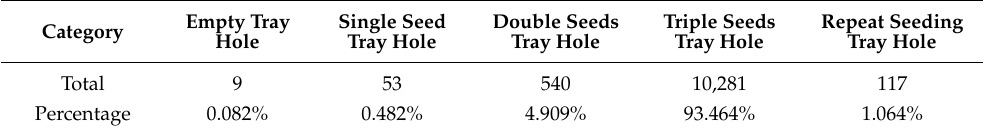
Figure 25. Some of the trays used in the experiment.